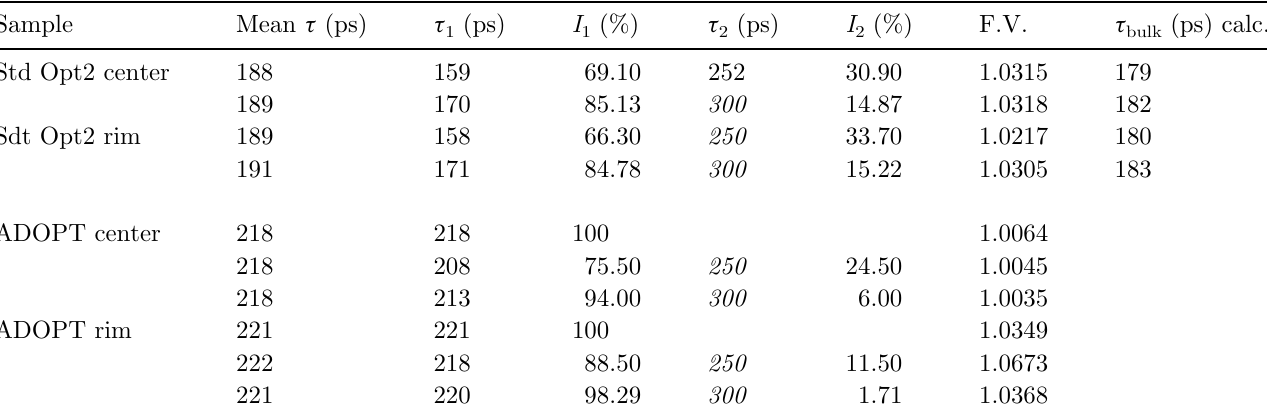
Table 1. Mean lifetimes t , fi rst and second components t indicate fi xed parameters during the decomposition. Reduced chi-squares F.V. are given for each fi t. Bulk lifetimes were calculated from the experimentally measured data according to the standard trapping model